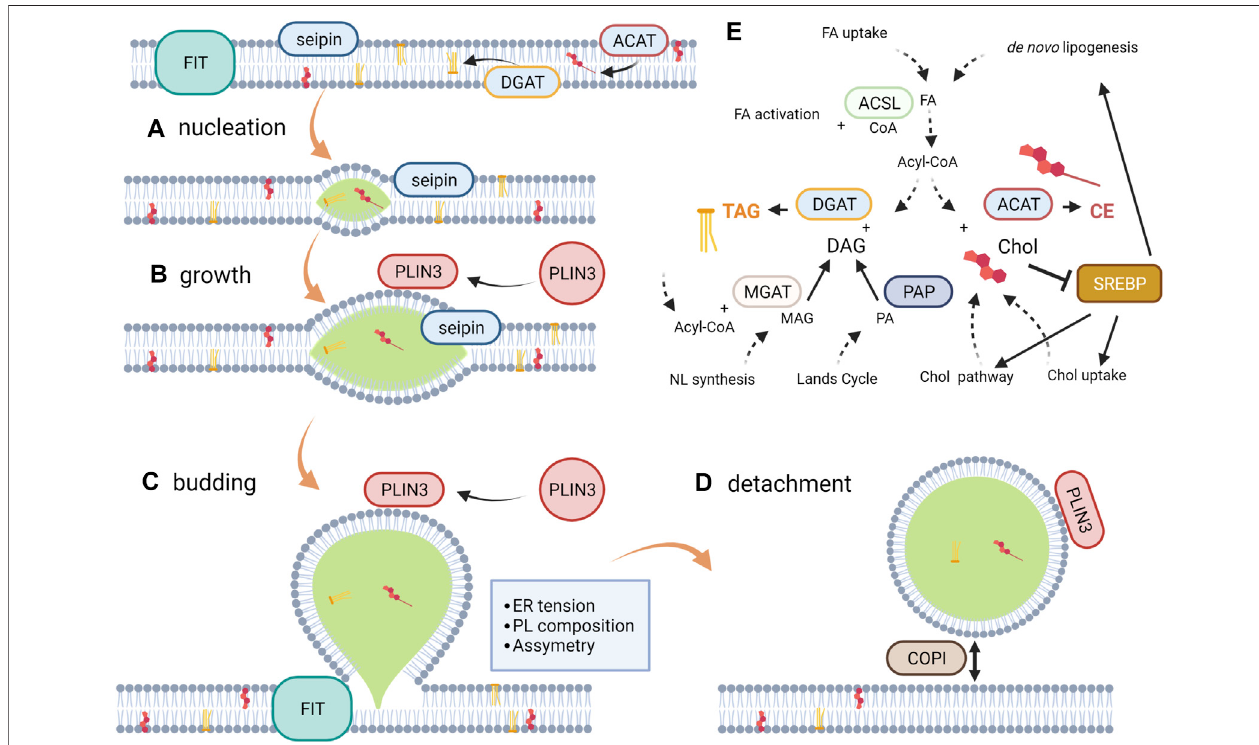
FIGURE 1 | LD Biogenesis. From a biophysical perspective, LD biogenesis can be described as a four-step process. (A) Nucleation occurs when the ER bilayer saturates with NL, reaching a concentration in the bilayer to form lenses of the size in the order of nanometers. The PL composition and seipin among other proteins modulates this process through bilayer hydration, bending and curvature. (B) The individual lens growth takes place as newly synthesized NL are incorporated and by ripening and fusion between lenses; seipin prevents NL from shedding. (C) Budding is a spontaneous process (dewetting) driven by the interfacial tensions that comeintoplaysurroundingthedroplet.Thebilayertensionandthephospholipidasymmetrydeterminethesphericityanddirectionofbudding,respectively.FIThasbeen recentlyproposedtobeinvolvedinthemaintenanceoftheappropriatePLcompositionineachERhemi-layer. (D) AlthoughdetachmentisnottobeexpectedforallLD,it is a reversible process. COPI has been proposed to be involved in the detachment/re-attachment process to the ER membrane. (E) Metabolic reactions more closely affecting NL synthesis and its modulating pathway SREBP. Note: the scheme represents a simpli fi cation of the metabolic vias according to the available evidence regarding the revised pathologies. For a more detailed description, see Pol et al.